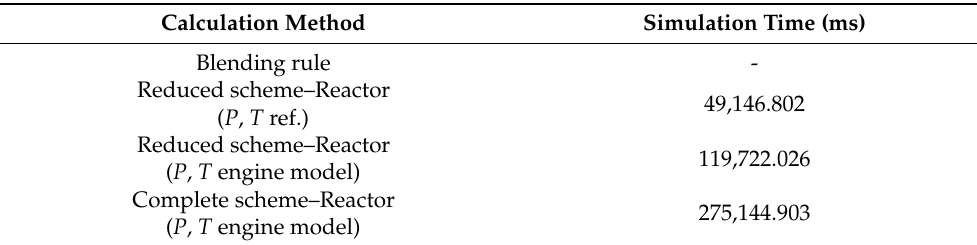
Figure 8. Absolute error distribution (Calc–Exp of RON) for the tested methods: blending rule (red), reactor with reduced scheme and P , T from ref. (green), reactor with reduced scheme and P , T from the engine model (orange), reactor with complete scheme and P , T from the engine model (blue). Table 5. Comparison between the computation time of the tested